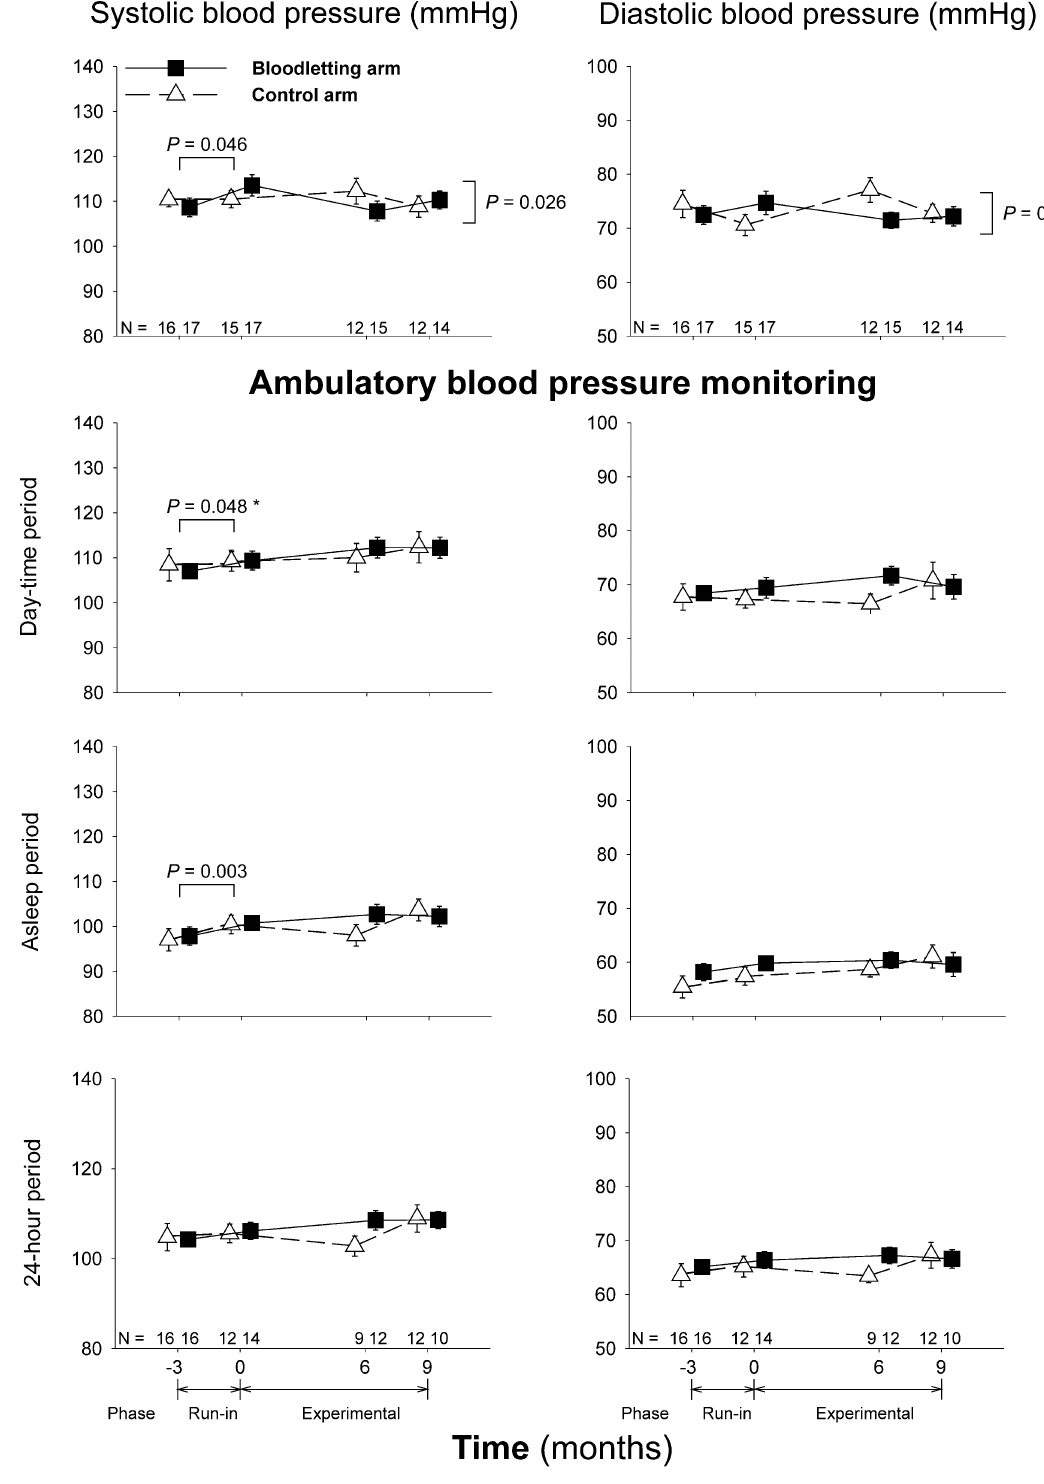
Figure 2. Changes in office blood pressure and ambulatory blood pressure monitoring recordings throughout the trial. Data are shown as means (SEM) of the patients remaining at each visit of the trial (figures above the x-axis) even though we conducted intention-to-treat statistical analyses. *Significant changes observed during the run-in phase in the whole group of participants after introducing the presence of obesity as between-subjects covariate. To analyze changes during the experimental phase, data were submitted to a repeated-measures general linear